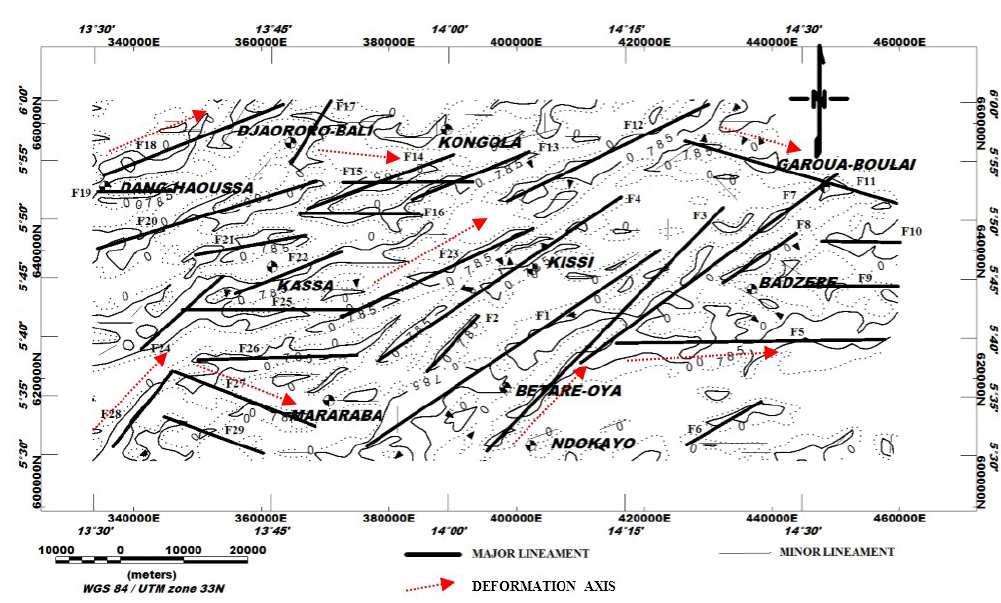
Figure 7. Major faults map superimposed on tilt-angle contours. On this map we observe the major regional deformation axes (NE–SW, E–W, ENE–WSW, and NW–SE) as well as the associated faults (F1 to F29).